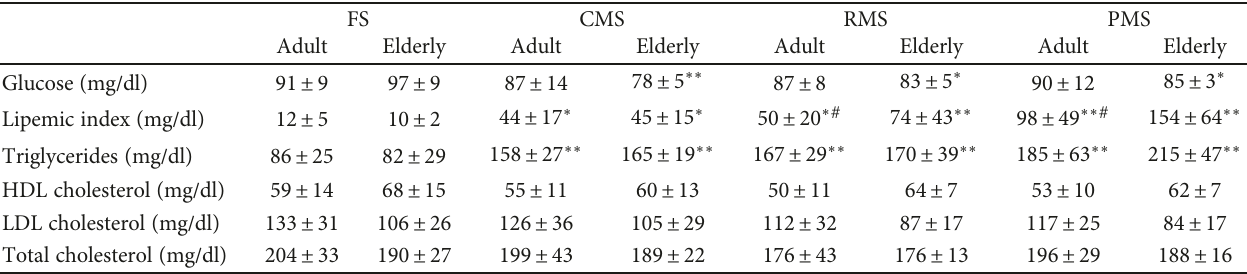
Table 1: Changes in the serum glucose, total cholesterol, HDL cholesterol, LDL cholesterol, triglyceride levels, and lipemic index after 4 h from the meat meal consumption. Data represent mean ± SEM.